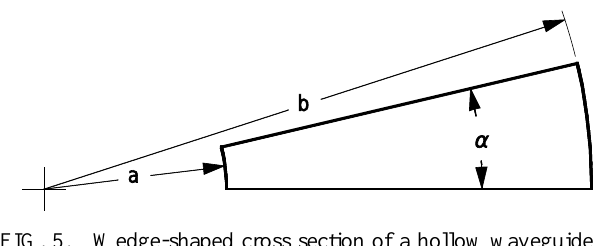
FIG. 5. Wedge-shaped cross section of a hollow